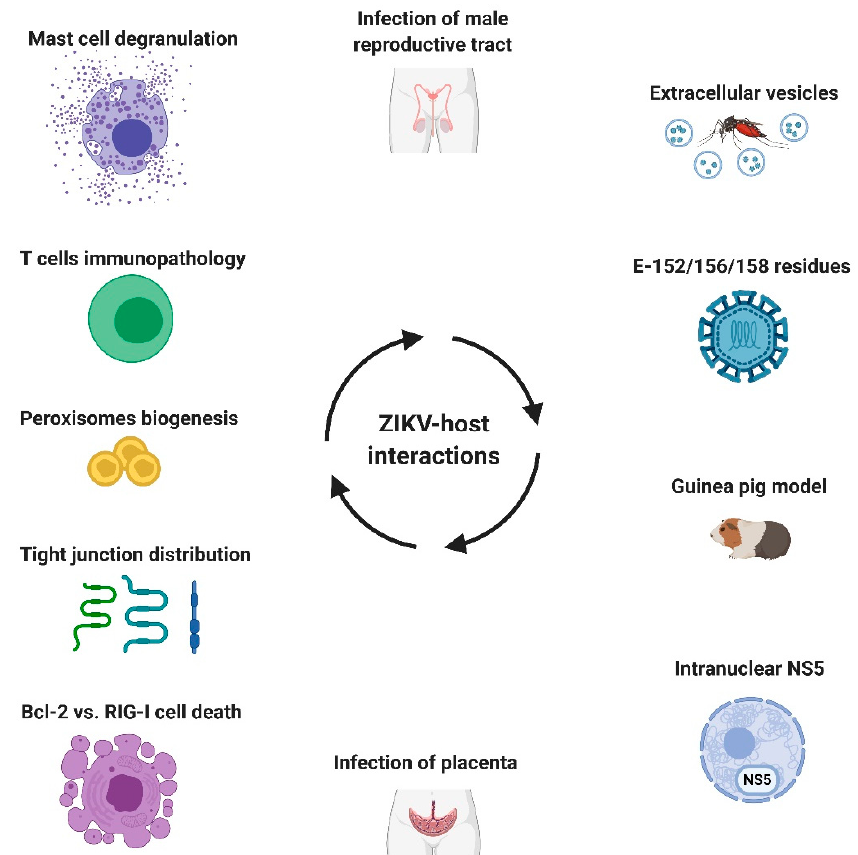
Figure 1. Zika virus (ZIKV)–host interactions. ZIKV and host interactions were addressed in this Special Issue by using in vitro, ex vivo, and animal models together with clinical samples. The complex interplay between host factors and viral components in different cell types and tissues dictates the outcomes of infection: aborted or productive infection, clinical presentation, and disease severity. Created with BioRender.com.